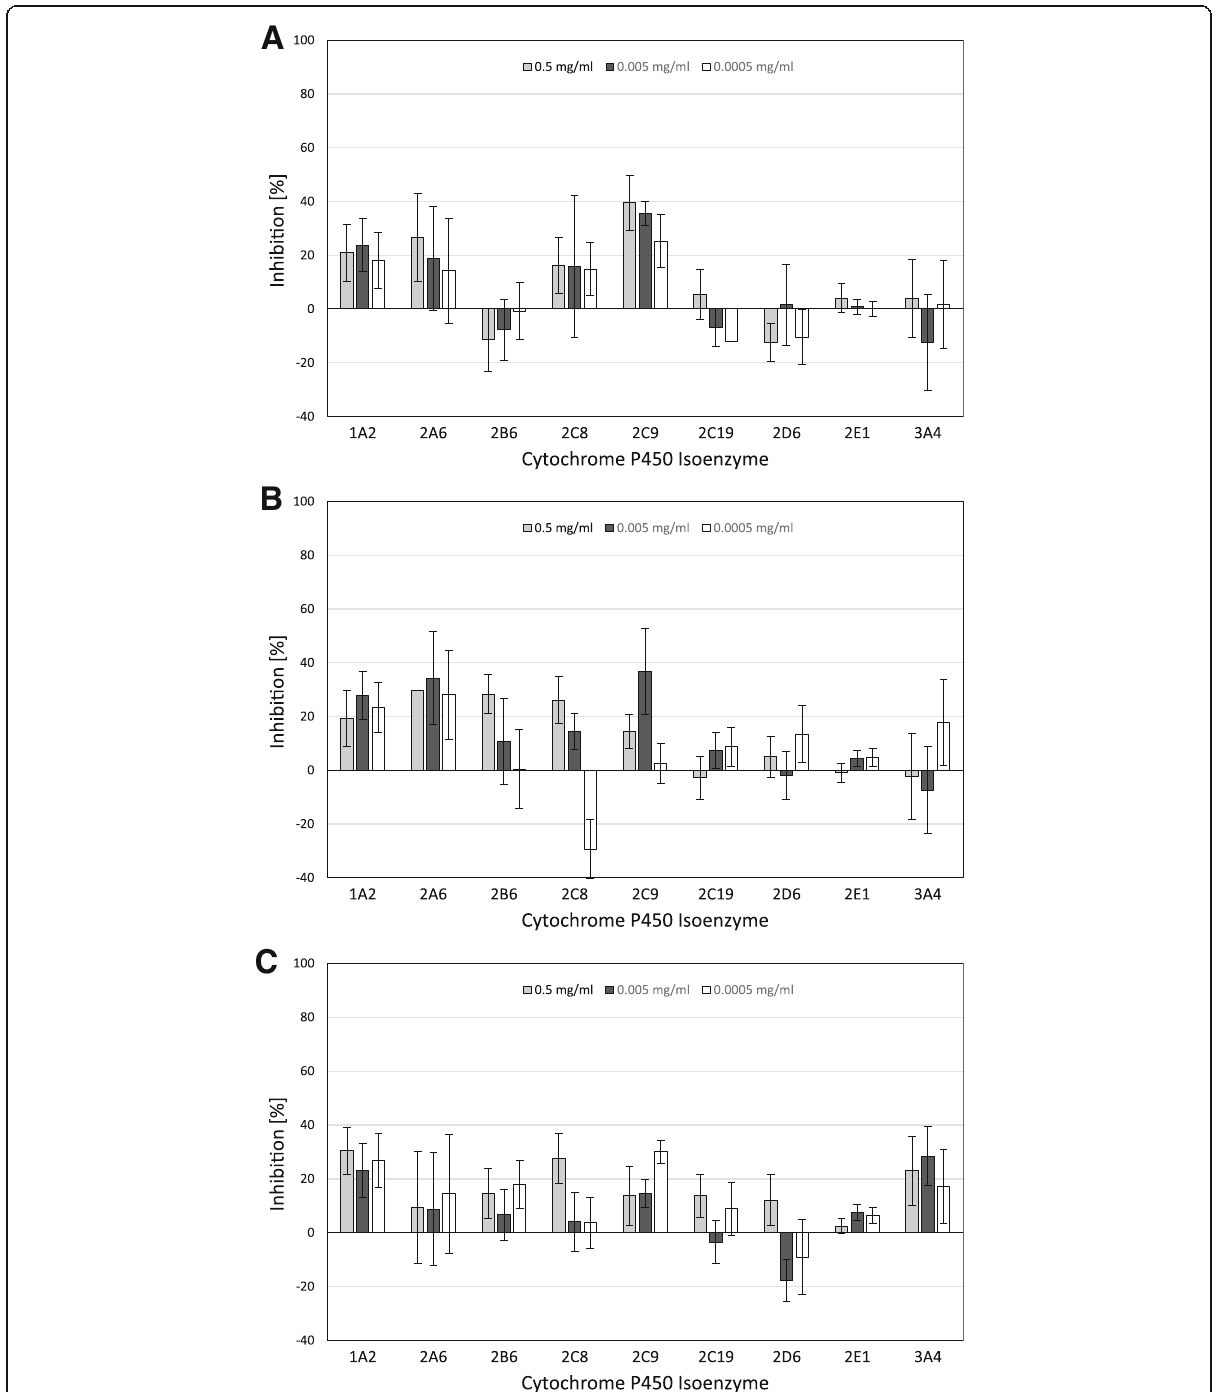
Fig. 1 Inhibition of CYP Marker Reactions in Human Liver Microsomes by Helixor® A ( a ), Helixor® M ( b ), and Helixor® P ( c )Effects of the mistletoe products on the metabolic activity of nine major human hepatic cytochrome P450 isoenzymes at 0.5 mg/ml (first bar), 0.005 mg/ml (second bar), and 0.0005 mg/ml (third